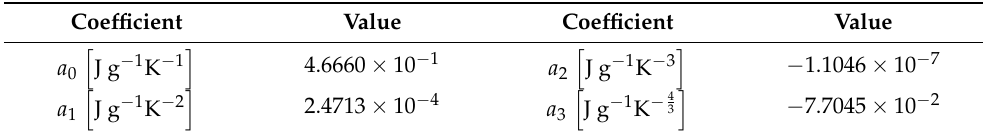
Table 4. Coefficients for calculating specific heat capacity of Maraging 350 samples in Equation (5).